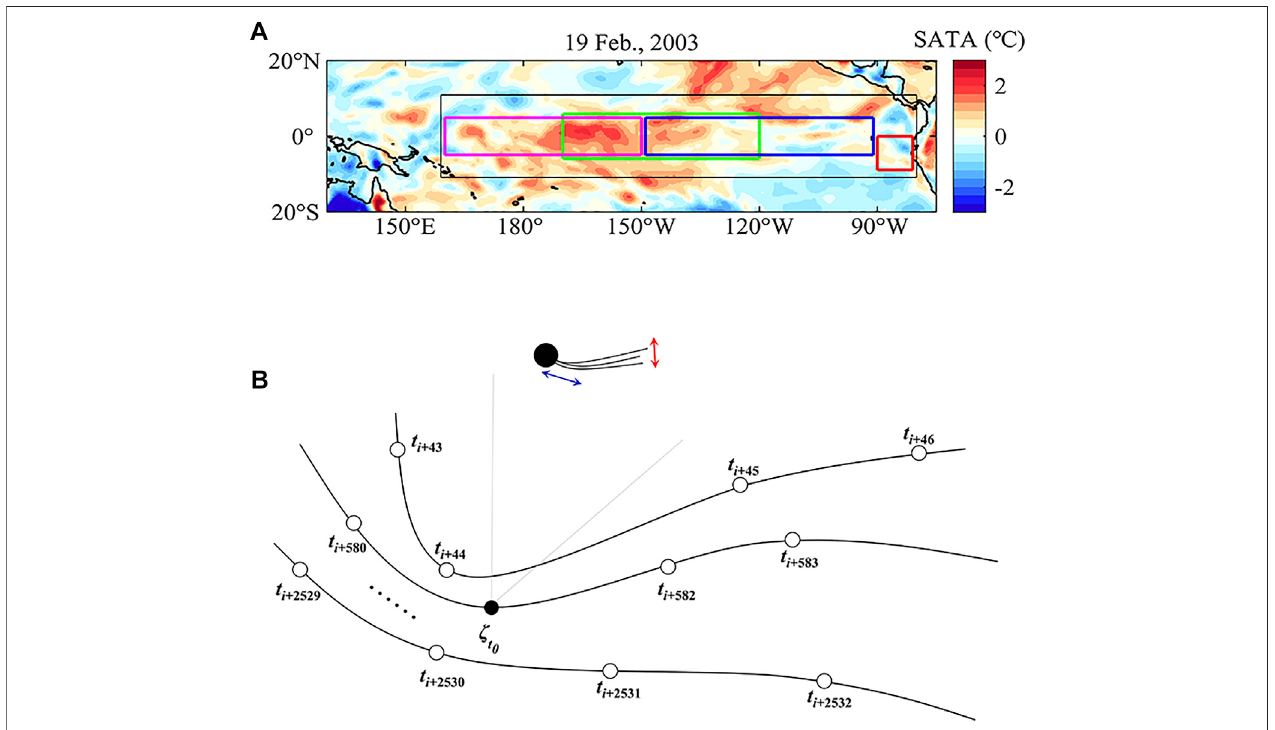
FIGURE1 | Illustrationofthe dynamical system analysis applied to theequatorial Paci fi cSATA. (A) Example ofareal-time SATAmap over theequatorial Paci fi con 19February2003.TheNiño1+2,Niño3,Niño4,andNiño3.4regionsareshownbyred,blue,purple,andgreenboxes,respectively.TheblackboxdenotestheSATA fi eld selectedtoconstructthedynamicalstatespace. (B) IdealizeddiagramofatrajectoryinthedynamicalstatespaceoftheSATA.Apoint ζ t the SATA latitude – longitude map at a certain time (as shown in Figure 1A). The zoomed sphere (black) shows the idealized schematic of the instantaneous persistence and dimension around ζ t 0